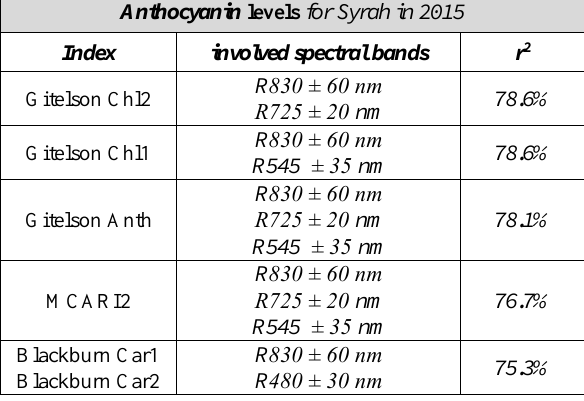
Table 5. The highest correlation rates regarding the estimation of Anthocyanin levels for Syrah in 2015